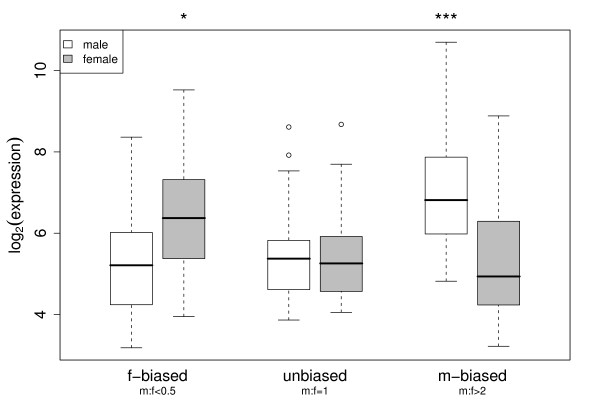
Relationship between sex bias in gene expression and expression level. Relationship of male-to-female ratios (m:f) with male (white) and female (gray) expression levels. While male expression is significantly higher for genes with high m:f ratio (m[ale]-biased) the opposite is indicated for genes expressed in females. Genes with a low m:f ratio (f[emale]-biased) are slightly more expressed in females. Asterisks indicate standard Type I error thresholds. Boxes include the 2nd and 3rd quantile; whiskers extend to the most extreme data points that lie within 1.5 times the interquartile range from the box; points depict extreme values beyond that boundary.